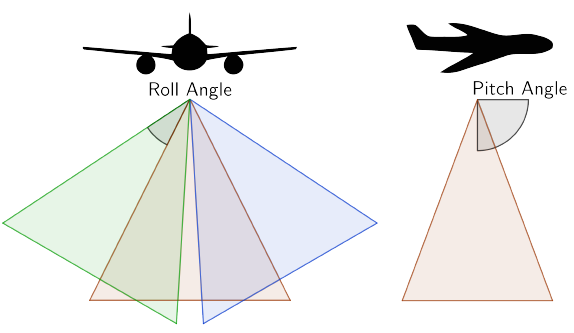
Figure 1. CAMPOS command